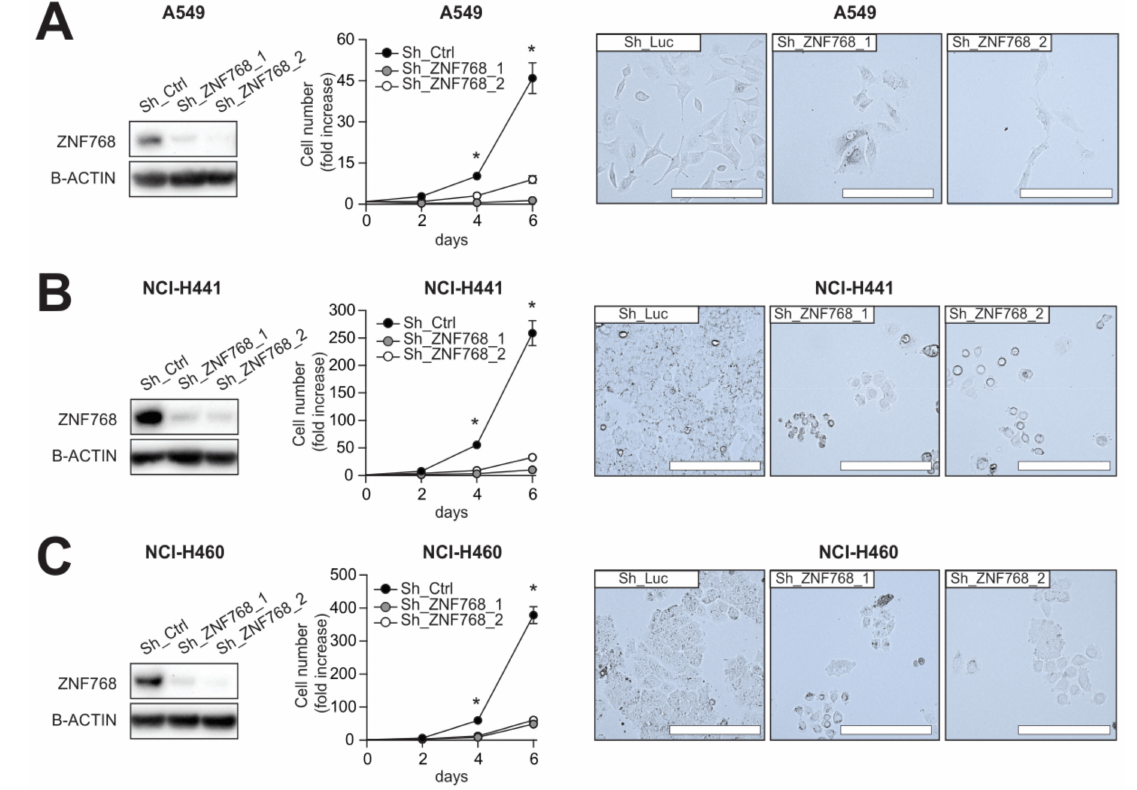
Figure 3. ZNF768 depletion impairs proliferation of various lung cancer cell lines. ( A ) A549 cells, ( B ) NCI-H441 and ( C ) NCI- H460 cells were transduced with lentivirus expressing shRNA targeting ZNF768. Cells were selected with puromycin and protein were extracted, or cells were plated and counted every two days. Pictures were taken on the last day of counting. Representative pictures are shown. Western blot analyses were performed to confirm ZNF768 depletion. This experiment was performed at least 2 times for each cell types and cell counts were done in triplicates. Significance was determined by Two-way ANOVA (* p < 0.05 versus